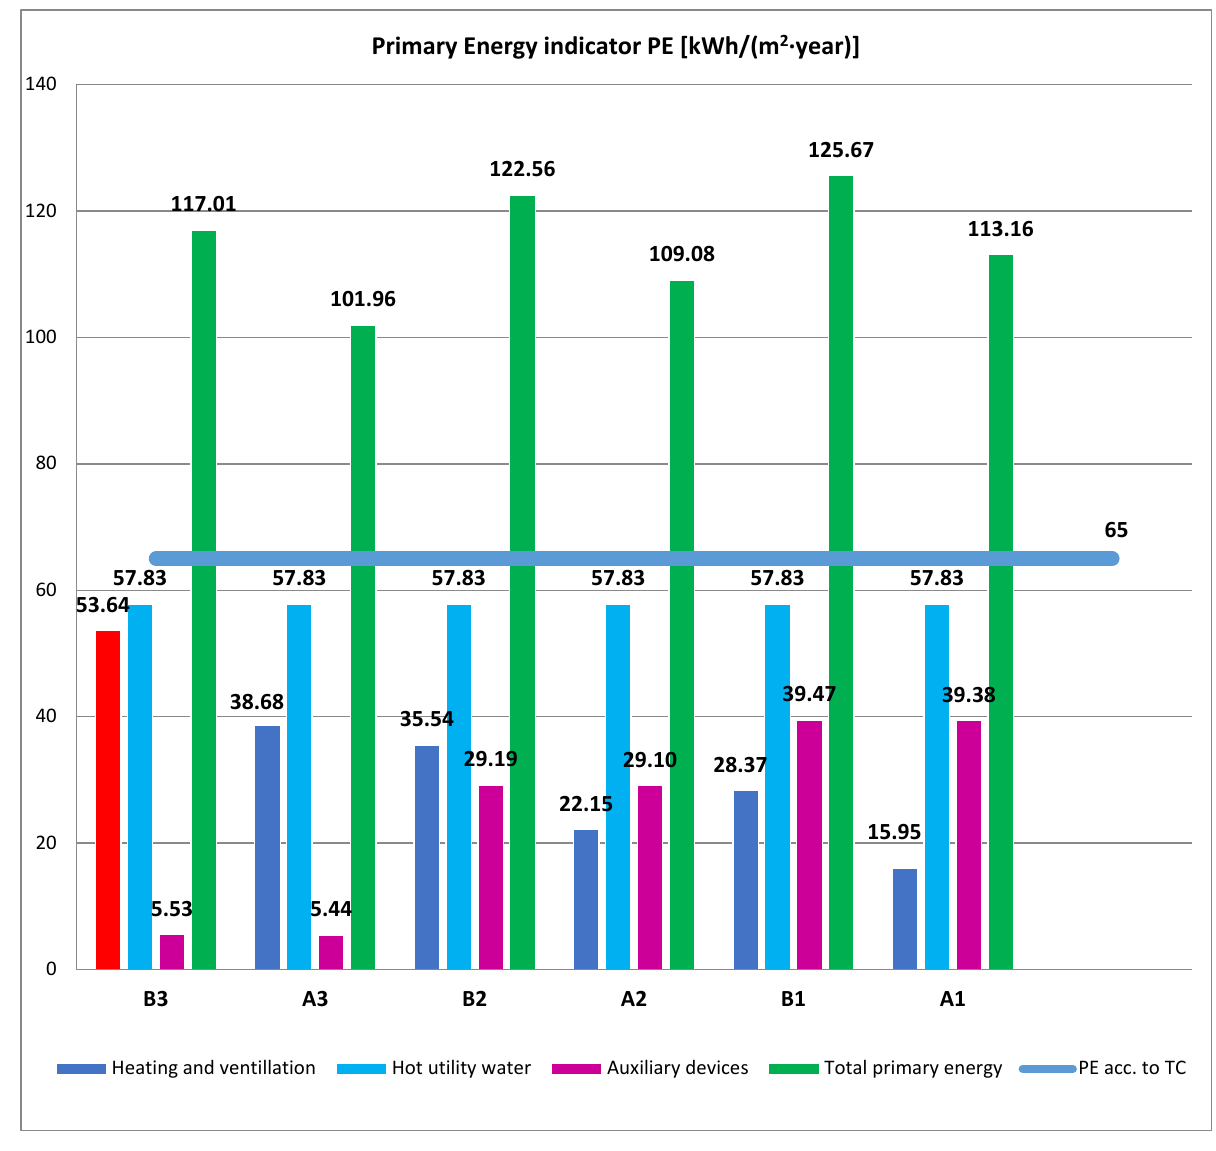
Scheme 3. Comparison of primary energy indicators PE for a building of a different energy class for the heat source: the gas boiler room.